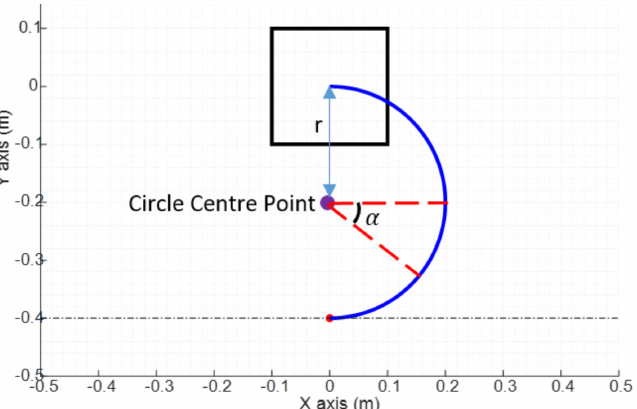
Figure 4. Starting configuration with the legs rotating point placed in the coordinates (0,